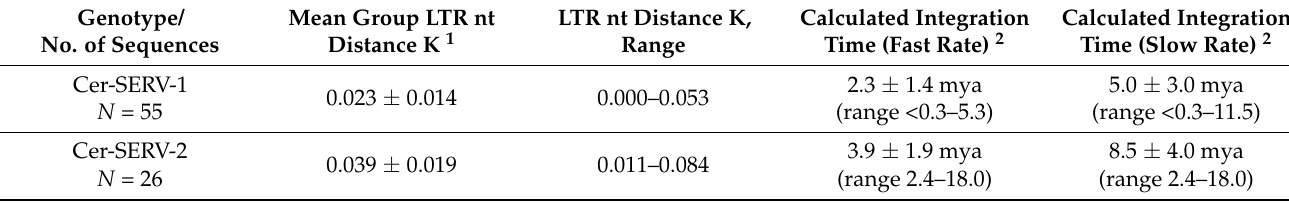
Table 2. 5 (cid:48) and 3 (cid:48) LTR nucleotide distances of Cer-SERV proviruses and their calculated integration times.